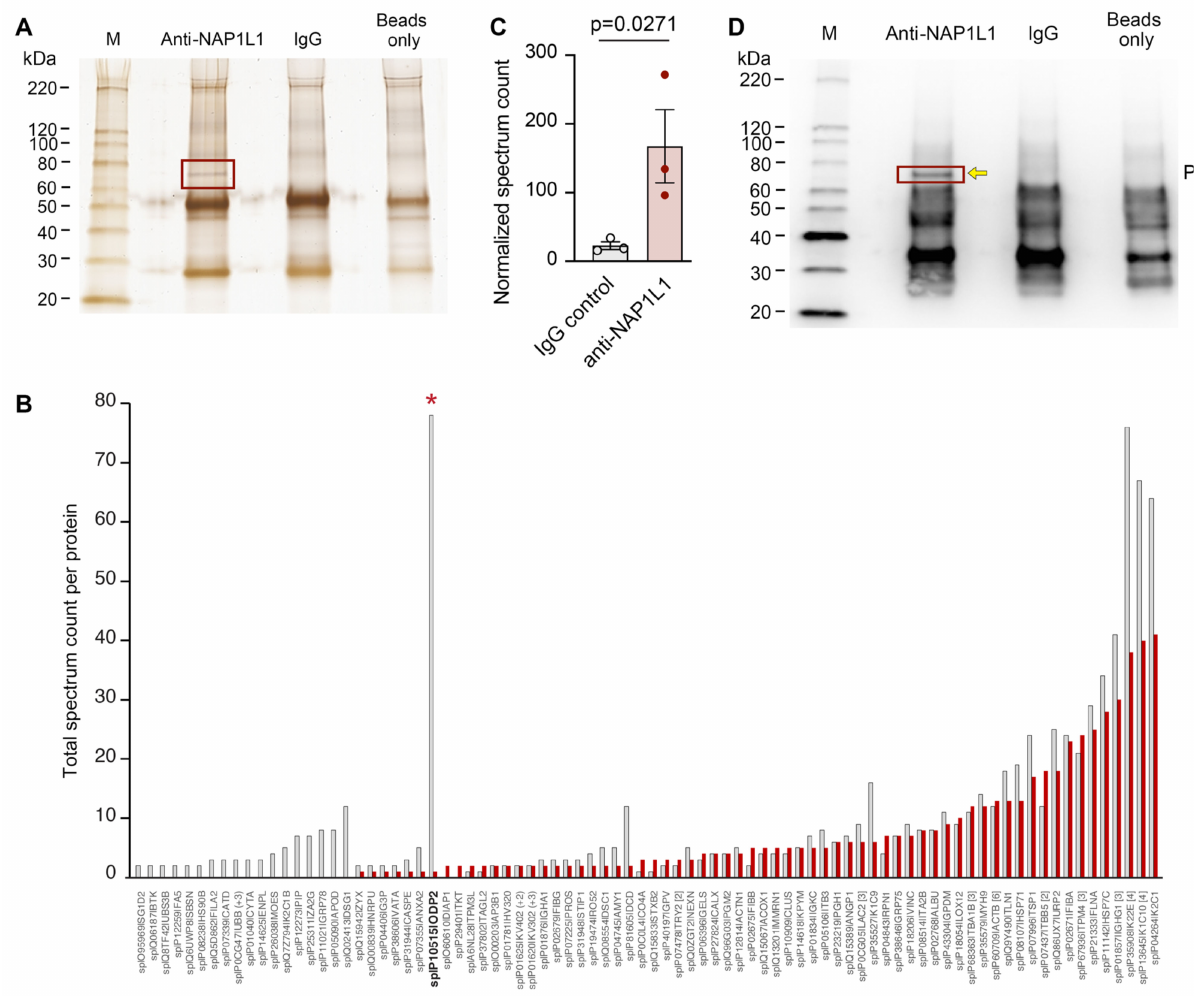
Figure 4. NAP1L1 directly interacts with PDC-E2. ( A ) Sodium dodecyl sulfate (SDS) gel were stained for total protein using standard MS-compatible silver staining. The left lane shows proteins isolated after co-immunoprecipitation (co-IP) using an anti-NAP1L1 antibody. The middle lane shows proteins isolated after co-IP with non-immunogenic, control IgG. The right lane shows proteins isolated after the use of protein-G beads only. Red box marks selected protein band subsequently used in MS analysis. This figure is representative of n = 5 independent experiments. ( B ) Bar graph showing the total spectrum count per protein. Black bars show counts for MS performed after control IgG experiment; non-filled bars demonstrated spectrum counts for proteins identified after co-IP using anti-NAP1L1. Total spectrum counts for PDC-E2 are indicated by red asterisk. ( C ) Bar graph showing the normalized spectrum count (normalized to all total spectrum counts) for PDC-E2. Black bar represents counts for MS performed after control IgG experiment; non-filled bar show spectrum counts for PDC-E2 identified after co-IP using anti-NAP1L1. This figure is representative of n = 3 independent experiments. Analyzed using t -test, p = 0.0271. ( D ) A corresponding sodium dodecyl sulfate (SDS) gel was analyzed using immunoblotting technique. Co-IP proteins were probed using an anti-PDC-E2 antibody. The left lane shows proteins isolated after co-immunoprecipitation (co-IP) using an anti-NAP1L1 antibody. The middle lane shows proteins isolated after co-IP with non-immunogenic, control IgG. The right lane shows proteins isolated after the use of protein-G beads only. Red box and yellow arrow mark PDC-E2 protein detected as being co-IP’ed using the anti-NAP1L1 antibody, indicating protein–protein interaction. This figure is representative of n = 3 independent